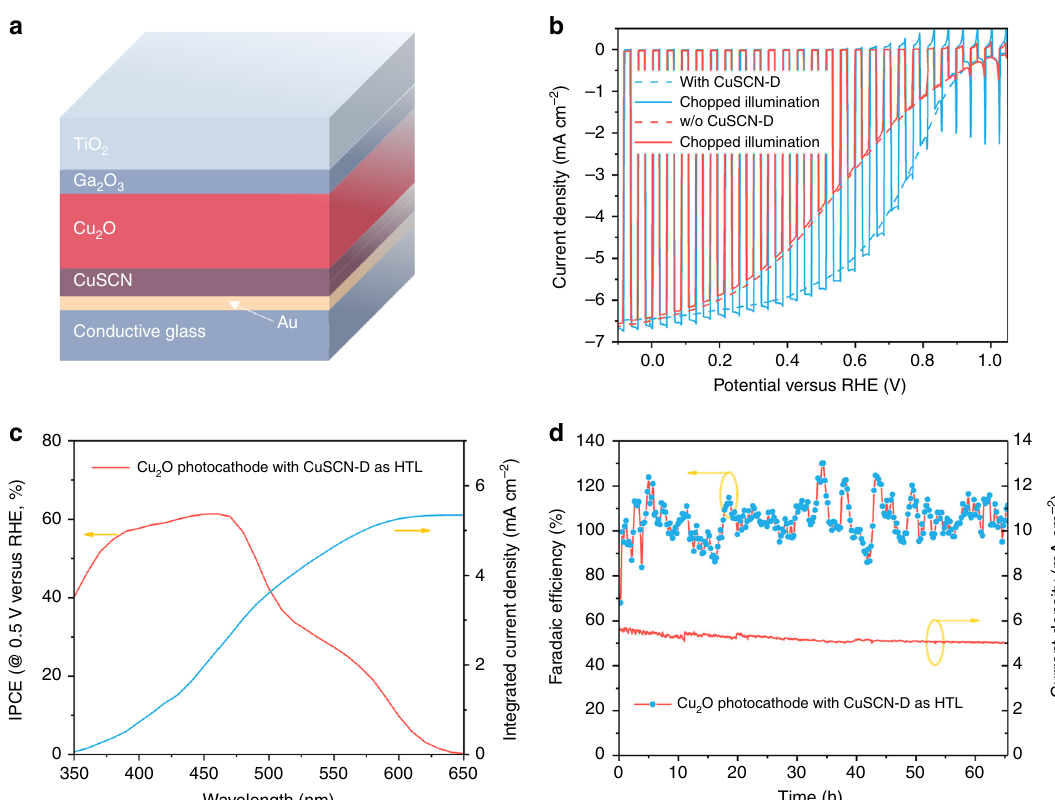
Fig. 2 Structure and PEC performance of CuSCN-incorporated Cu 2 O photocathodes. a A schematic diagram of the CuSCN-incorporated Cu 2 O photocathode con fi guration. b Current density-potential ( J-E) responses of Cu 2 O photocathodes with or w/o CuSCN-D layer under simulated one-sun illumination (air mass 1.5 G spectrum) in pH 5 buffered electrolyte (scan rate 10 mV/s). c Wavelength-dependent IPCE and integrated current density of Cu 2 O photocathodes with CuSCN-D layer. All photocathode tests are carried out on photocathodes with 2 min electrodeposited CuSCN-D layers. d Stability test at fi xed bias of 0.5 V versus RHE and corresponding Faradaic ef fi ciency for hydrogen evolution in pH 5 buffered electrolyte